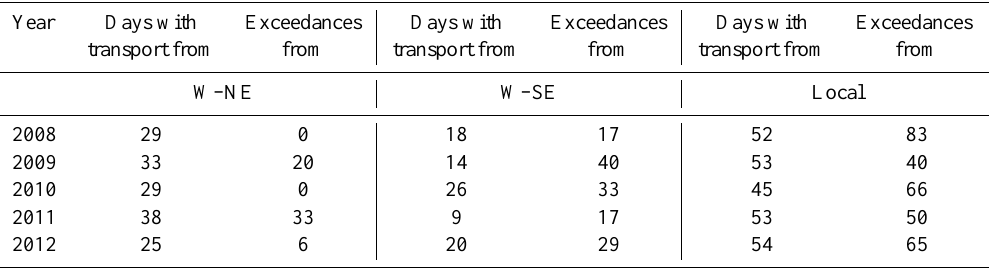
Table 1. Percentage of days and exceedances (at Downtown2) each summer (2008–2012) that were affected by air transport from the W to the NE, the W to the SE or local/stagnant air. Year Days with Exceedances Days with Exceedances Days with Exceedances transport from from transport from from transport from from W–NE W–SE